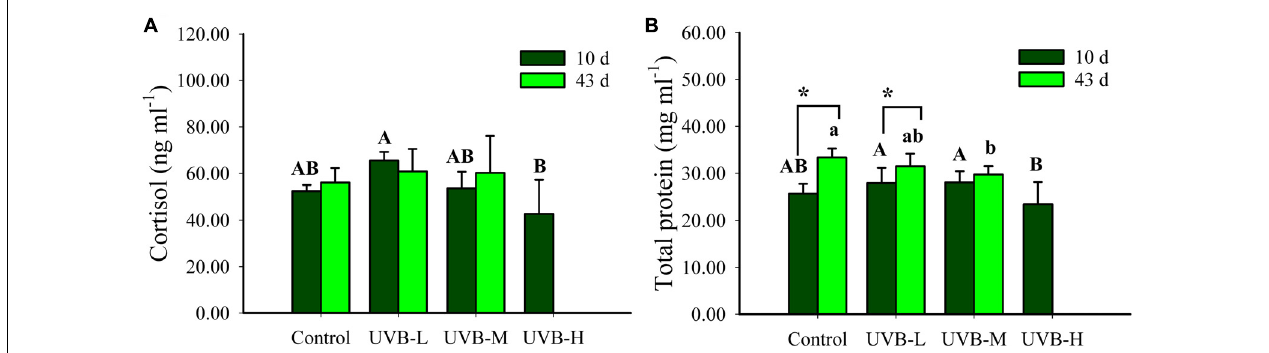
FIGURE 4 | (A) Cortisol (ng ml − 1 ) and (B) total protein (mg ml − 1 ) in plasma of S. aurata after 10 and 43 days of exposure to UVB (cortisol: mean ± SD, 10 days n = 8, 43 days n = 10; total protein: mean ± SD, 10 days n = 18, 43 days n = 12). Significant differences between treatments after 10 and 43 days of UVB exposure are represented by upper and lower case letters, respectively ( P < 0.05; two-way ANOVA). Within the treatment, * indicates significant differences between 10 and 43 days of UVB exposure ( P < 0.05; two-way